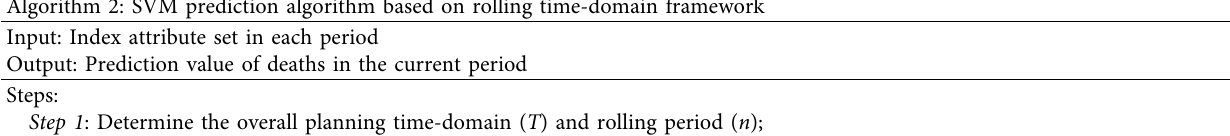
Table 3: Steps and pseudocodes of prediction algorithms. Algorithm 2: SVM prediction algorithm based on rolling time-domain framework